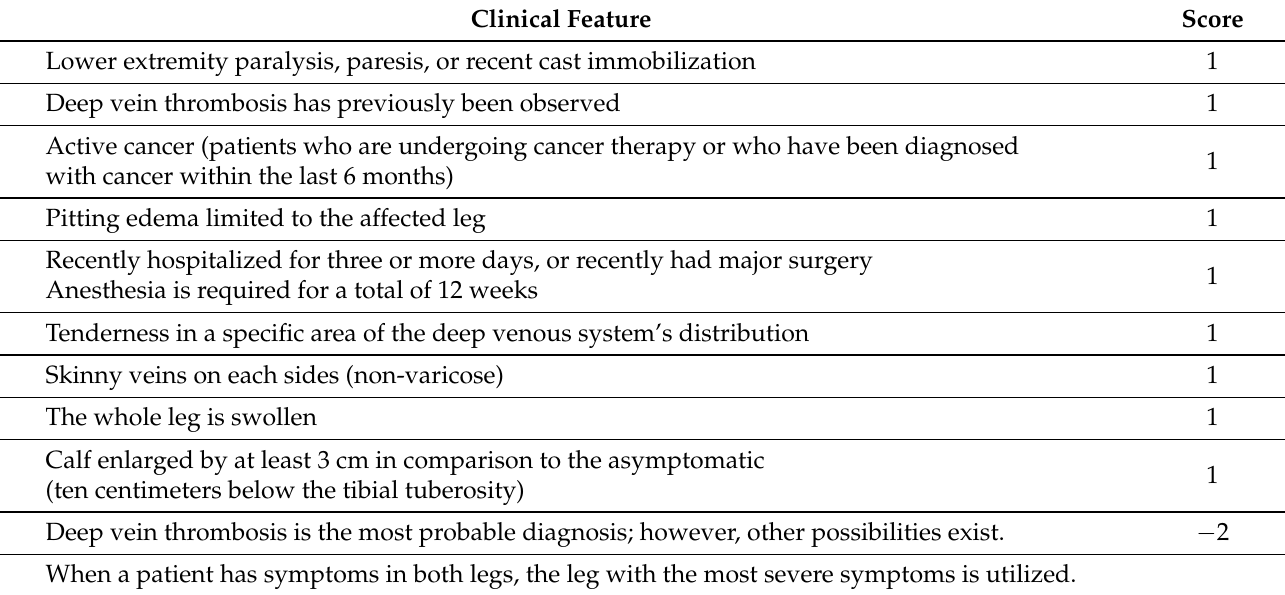
Table 2. Wells criteria for predicting deep vein thrombosis (DVT), taken from [10,53–55].